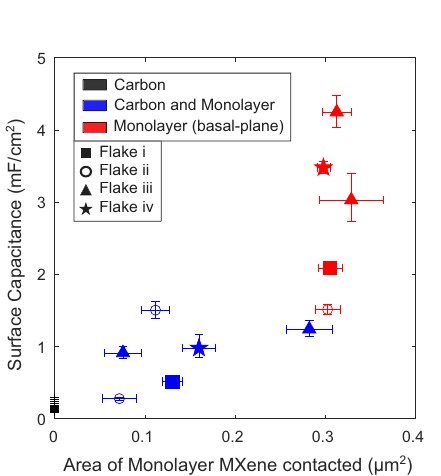
electrochemical contact with electrolyte. c Speci fi c gravimetric capacitance obtained by normalizing by the total mass of the monolayer fl ake. Error bars represent the standard deviation from determination of b MXene mass contacted and c MXene fl ake